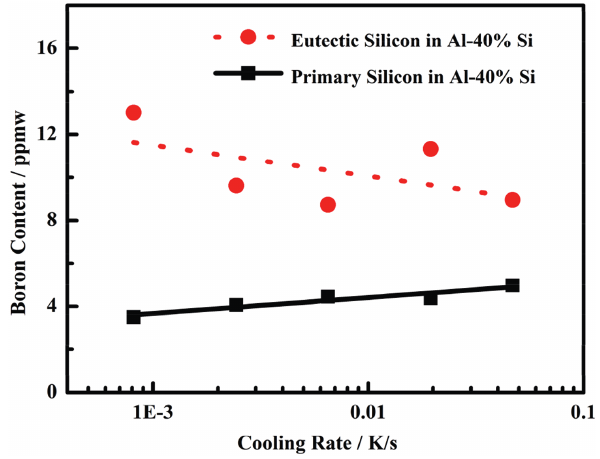
Figure 2: Boron contents in the primary silicon phases and eutectic silicon phases in the Al-40% Si